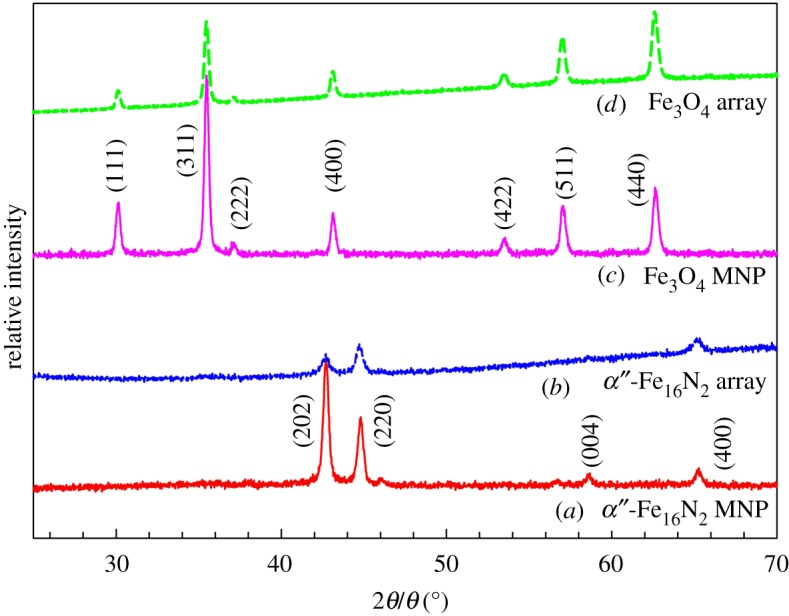
XRD patterns of (a) core–shell α″-Fe16N2/Al2O3 MNPs and (b) their assembled arrays, (c) Fe3O4 MNPs and (d) their assembled arrays.